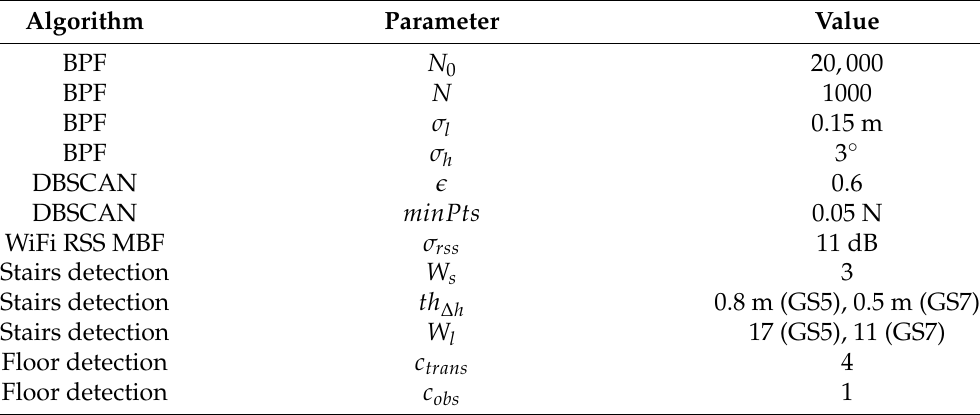
Table 1. Important parameters for the localisation and floor detection algorithms. GS5 and GS7 are abbreviations for the Samsung Galaxy S5 and S7 smartphones,